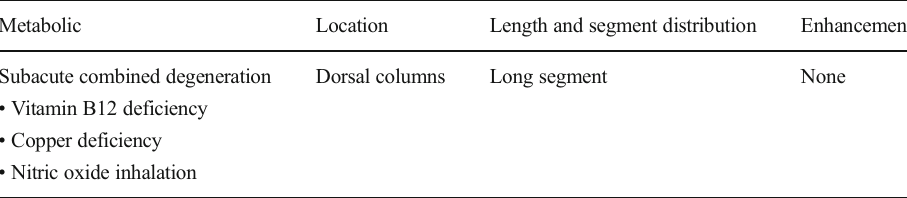
Table 2 Metabolic condition